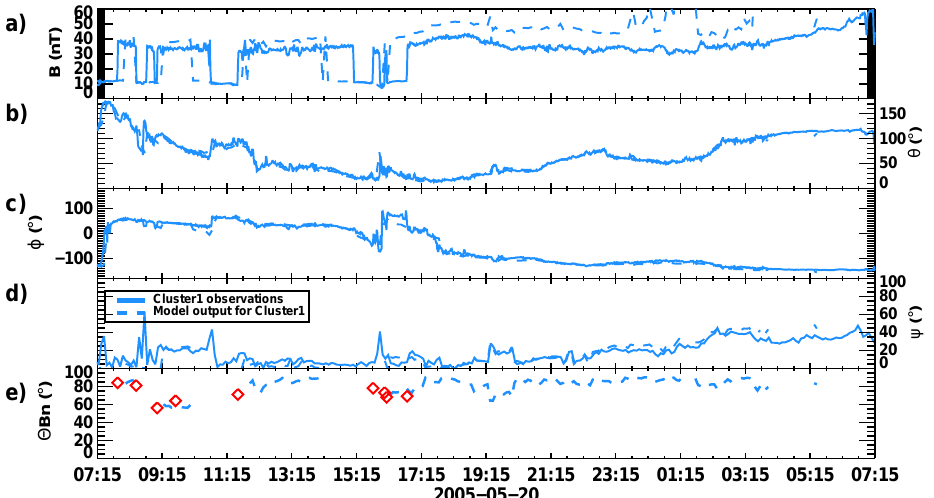
Figure 6. 20 May 2005 MC: comparison between the magnetosheath model’s results (dashed blue lines) and Cluster’s observations (solid blue lines), in GSE coordinates. From top to bottom: magnetic field strength, θ , ϕ , ψ and 2 Bn . Red diamonds: 2 Bn estimated with MVA from the